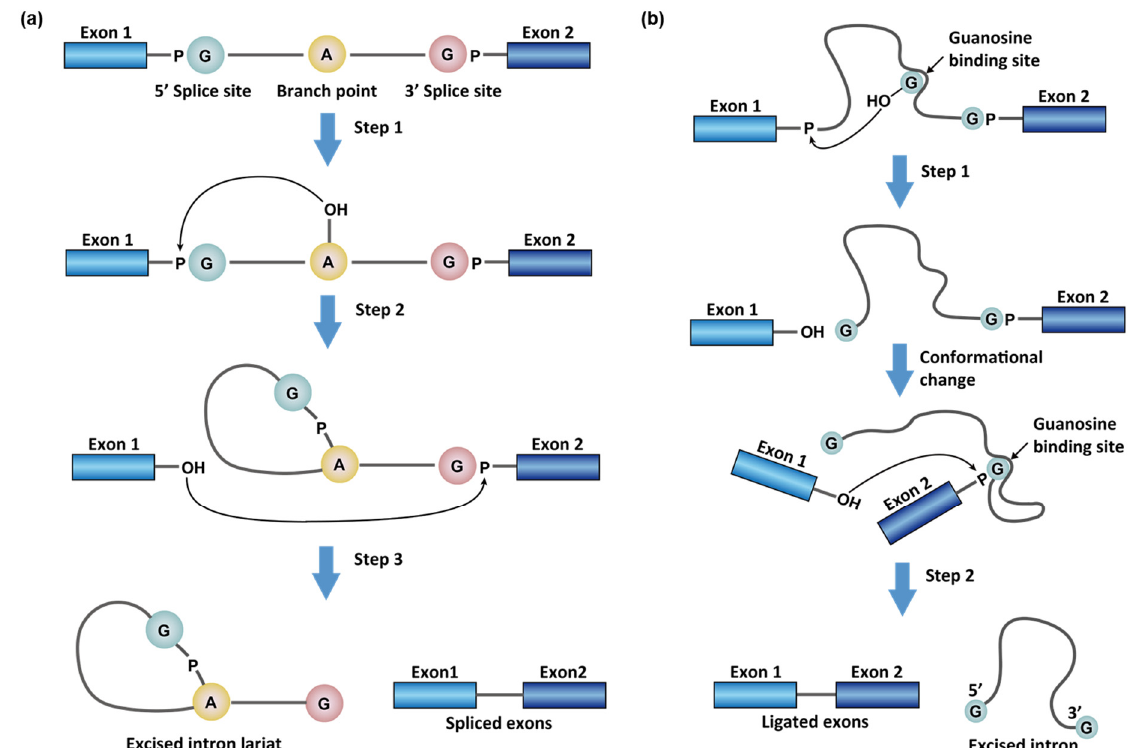
Figure 1. Splicing reaction with ( a ) adenosine as the branch point, which occurs in spliceosome-dependent splicing and group II introns, and ( b ) exogenous guanosine binding in the group I introns.